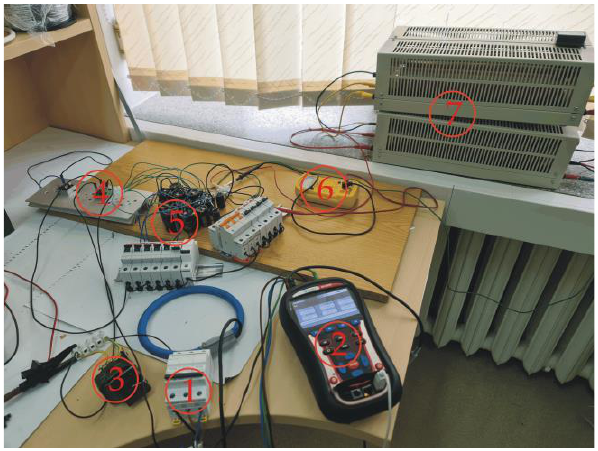
Figure A7. Photo of experimental setup for the reactive power provided or drawn out by diode rectifier supply-side device analysis.